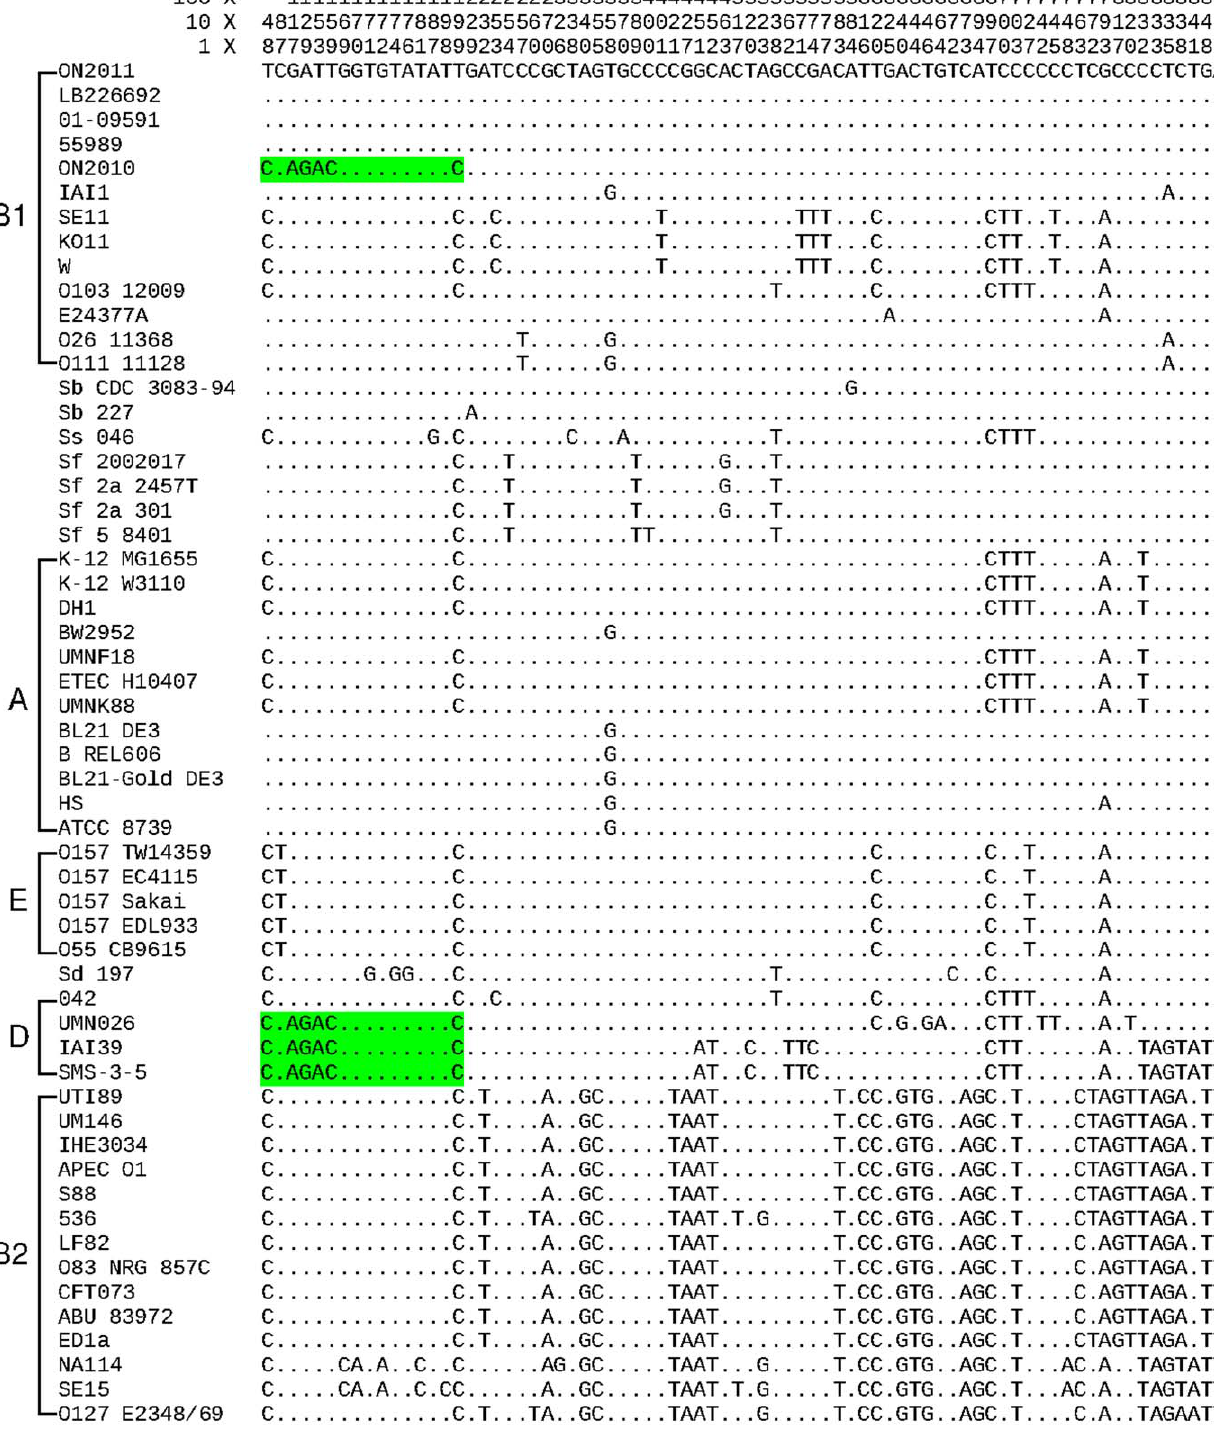
utility of traditional methods for bacterial identification and classification, higher resolution methods are necessary to under- stand the evolution and emergence of new pathogens. To be effective, pathogen surveillance should include methods that